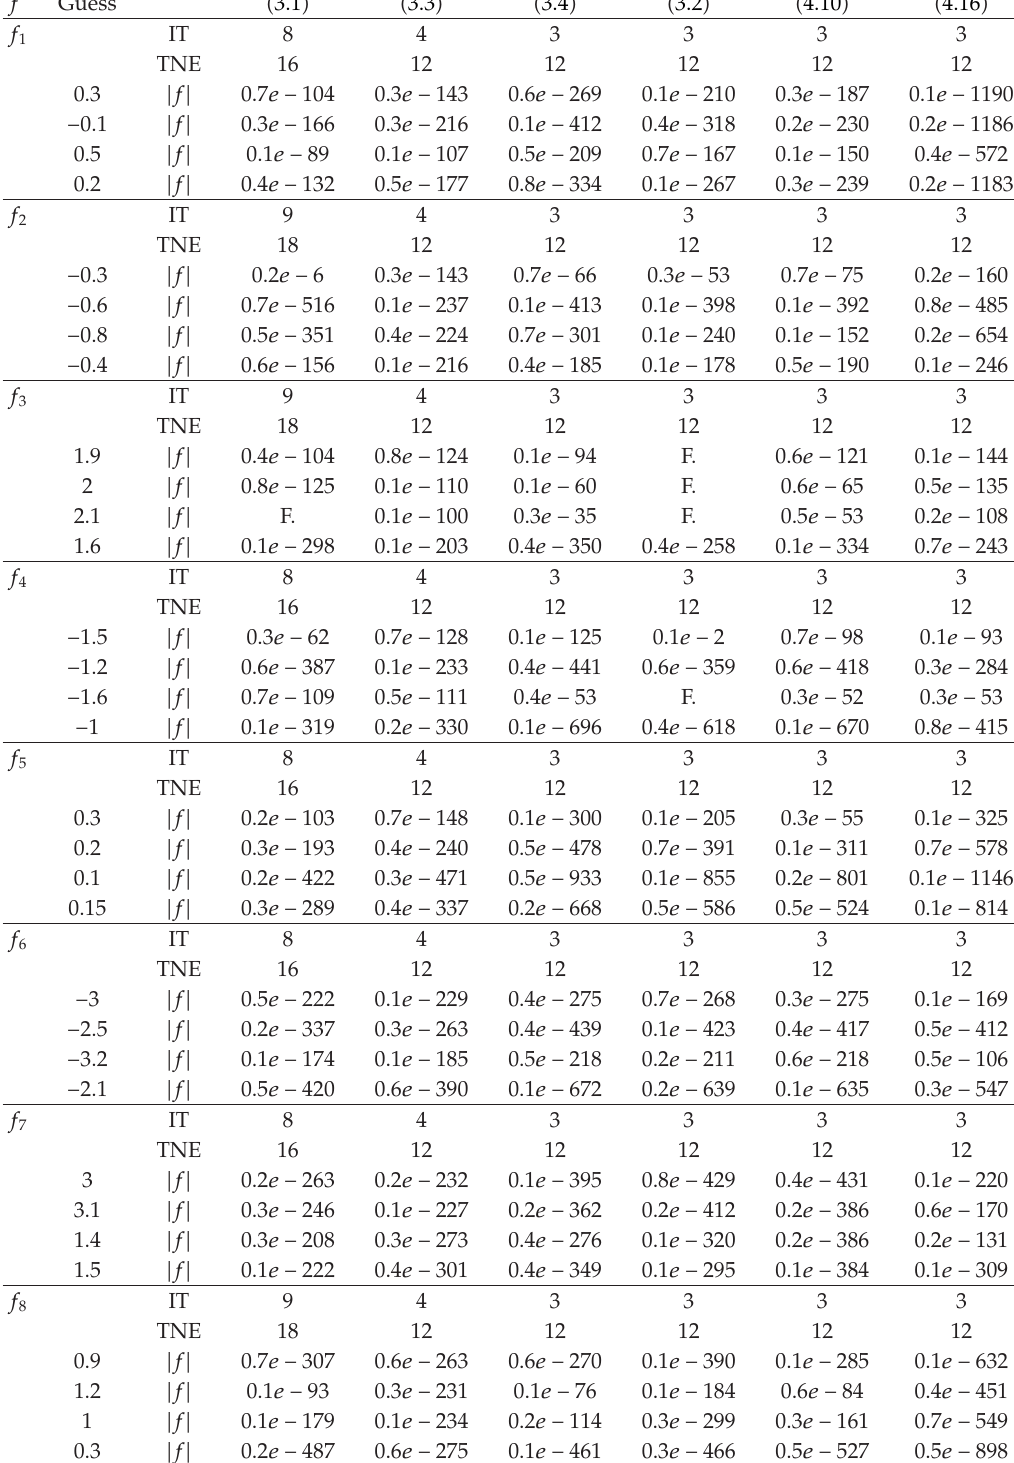
Table 2: Results of convergence under fair circumstances for di ff erent derivative-free